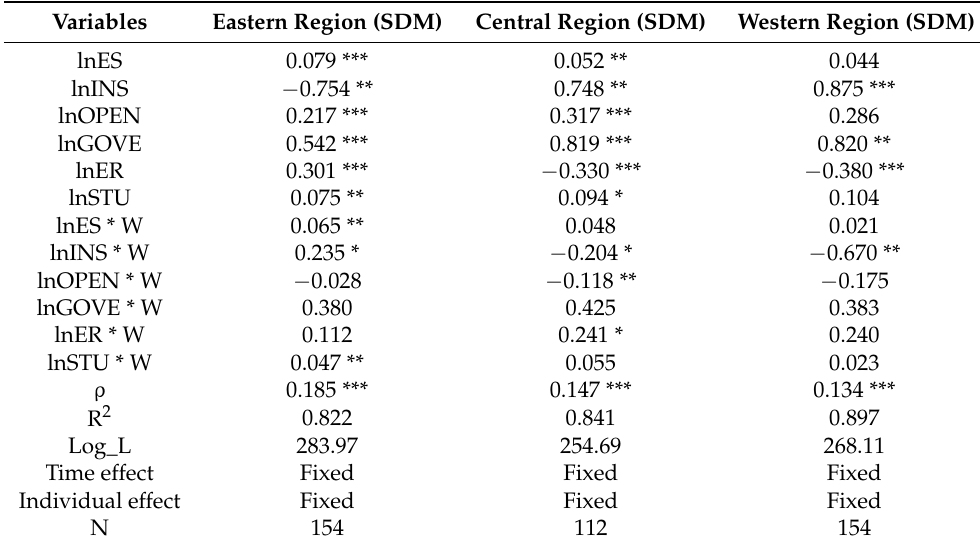
Table 4. Spatial econometric regression results of Eastern, Central and Western in China.